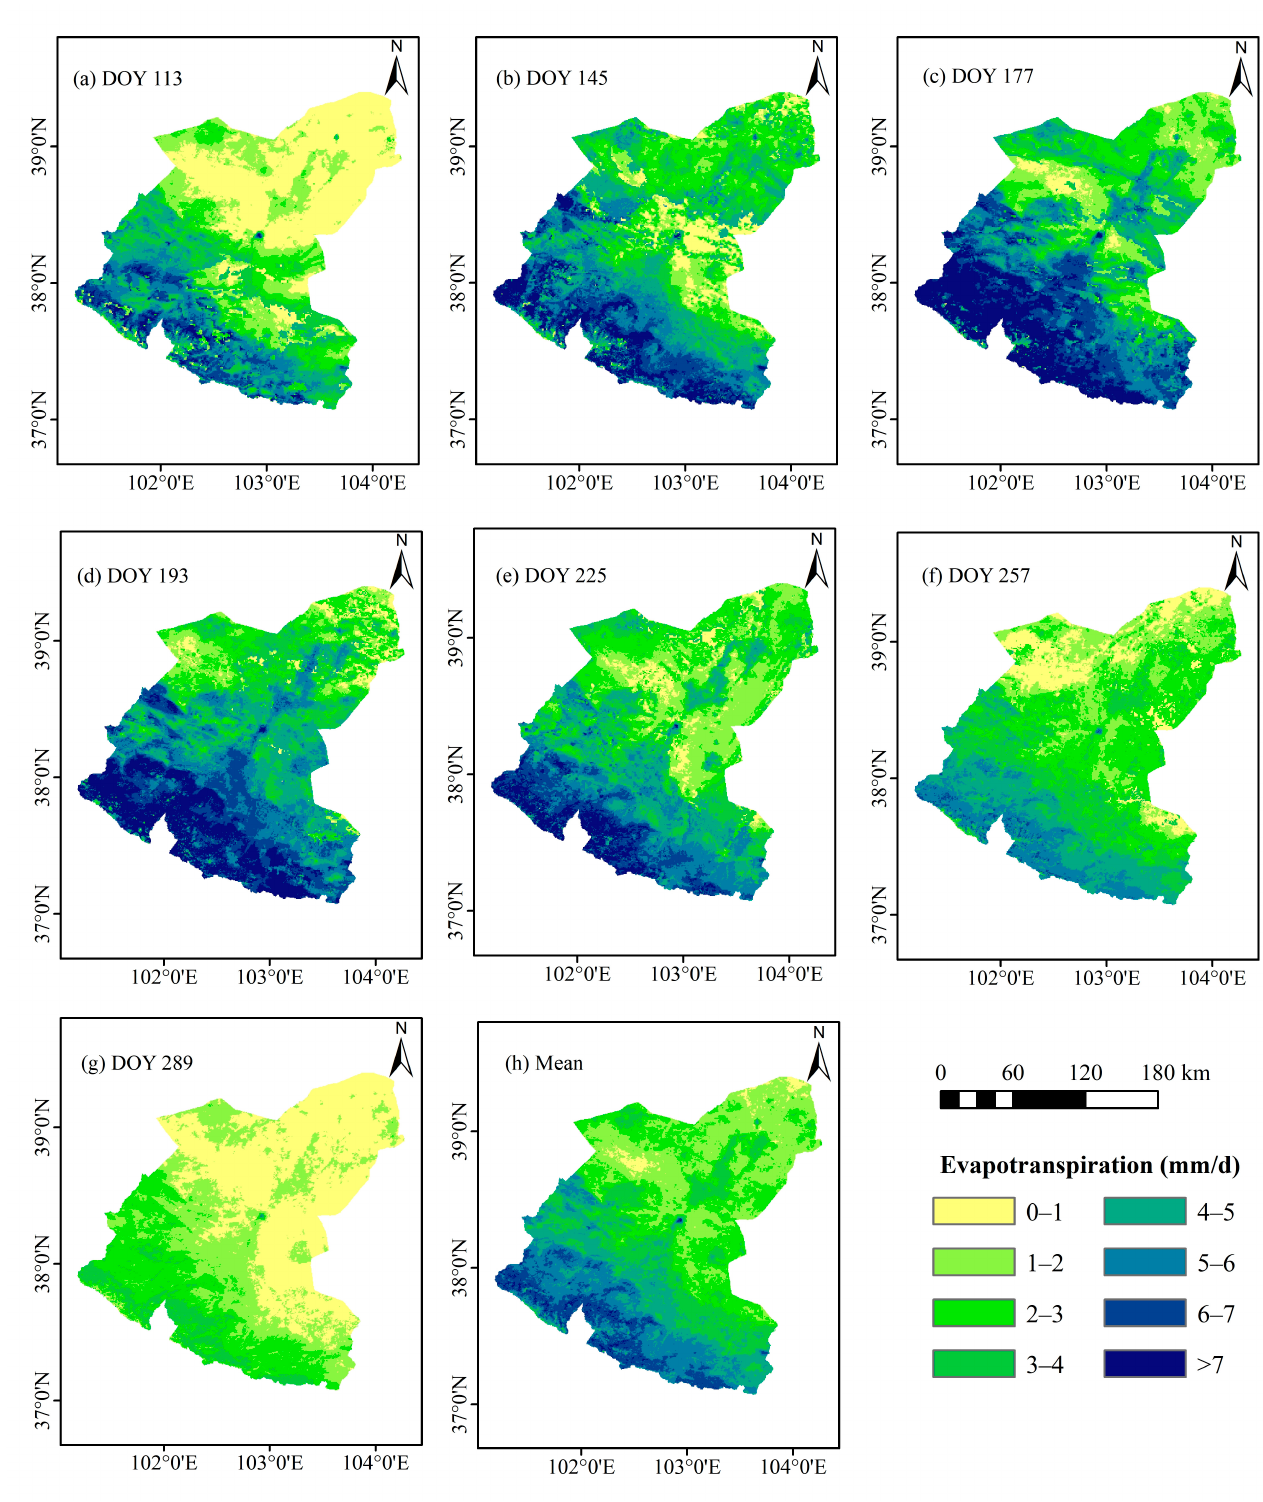
Figure 5. Spatial and temporal distribution of ET d in the study area in 2020. ( a ) DOY 113 (22 April); ( b ) DOY 145 (24 May); ( c ) DOY 177 (25 June); ( d ) DOY 193 (11 July); ( e ) DOY 225 (12 August); ( f ) DOY 257 (13 September); ( g ) DOY 289 (15 October); ( h ) 7-day mean ET. To accurately understand the spatial variation of ET in the study area, the 7-day av- erage ET d was calculated for each pixel (Figure 5h). The mean ET d in the study area varied between 0.23 and 7.83 mm/d during the growing season, with a mean ET d value of 3.45